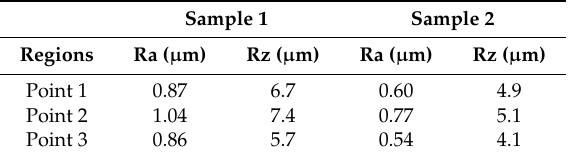
Table 10. Micrometric roughness values obtained by a linear roughness meter in July Table 9. Micrometric roughness values obtained by linear roughness meter in June 2019.